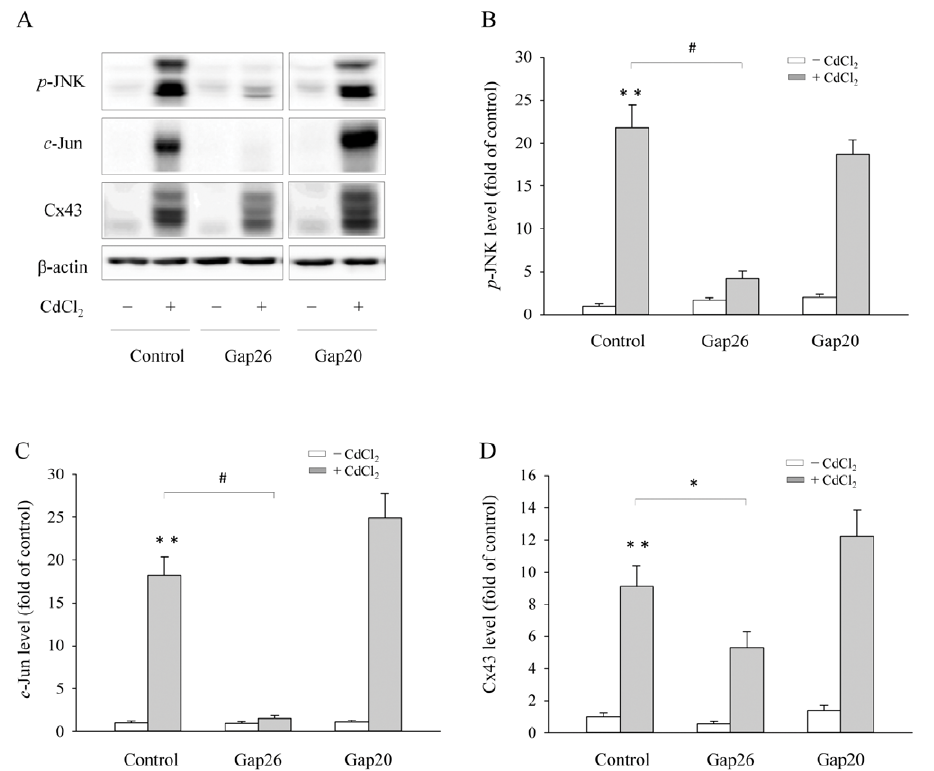
Figure 5. Effects of various connexin (Cx) mimetic peptides on Cx43 and p -JNK, c -Jun levels. (A) Cx43-LLC-PK1 cells were pretreated with various Cx mimetic peptides, Gap20, and Gap26 at the concentration of 100 m M for 1 h, and then exposed to 35 m M Cd 2 + in the presence of the peptides for additional 6 h. Cellular protein was subjected to Western blot analysis for p -JNK, c -Jun, Cx43 and b -actin. Densitometric results (B–D) were expressed as induction relative to the basal level of p -JNK, c -Jun and Cx43, respectively (mean 6 S.D., n=3). # p , 0.01 and * p , 0.05 versus Cd 2 + alone, and ** , 0.01 versus untreated control.